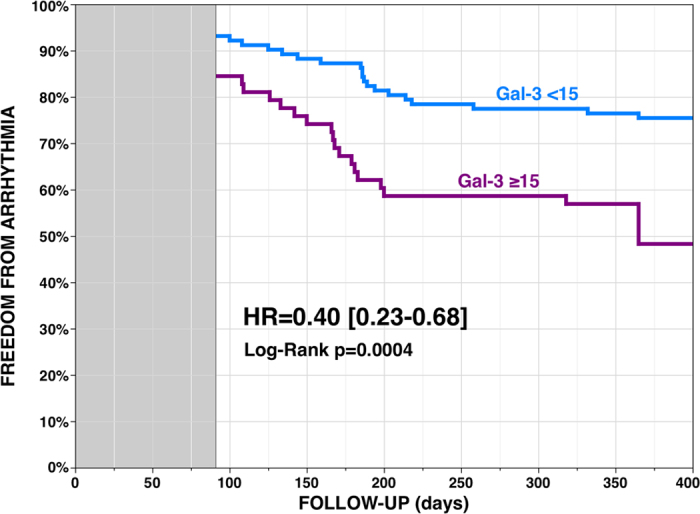
Arrhythmia-free survival without anti-arrhythmic drug after a single ablation procedure according to galectin-3 baseline serum level, <15 (N = 102, 64%) or ≥15 ng/mL (3-month blanking period).